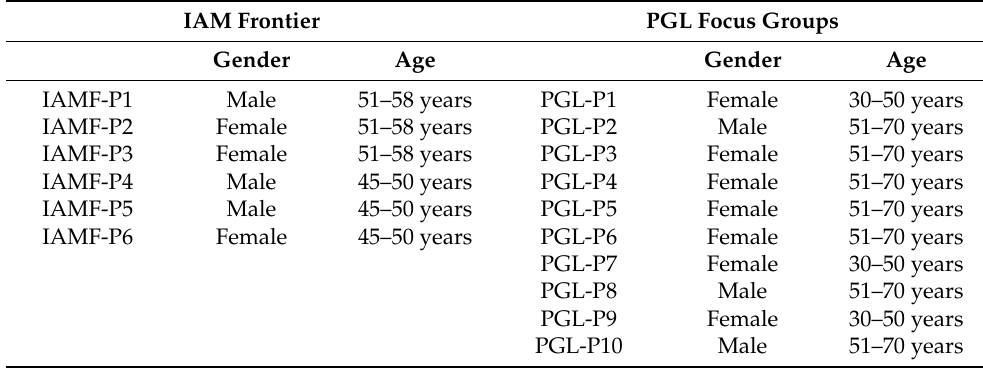
Table 2. Overview of participants in IAM Frontier interviews and PGL focus